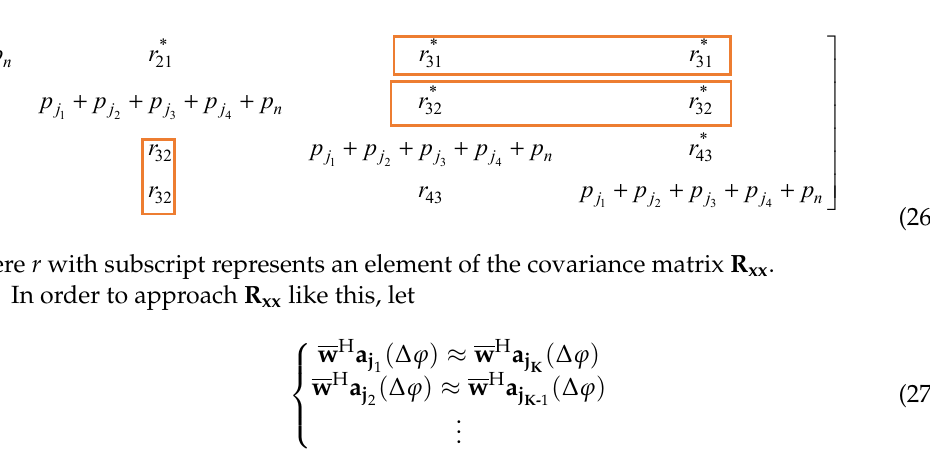
Figure 4. The selection of initial iteration